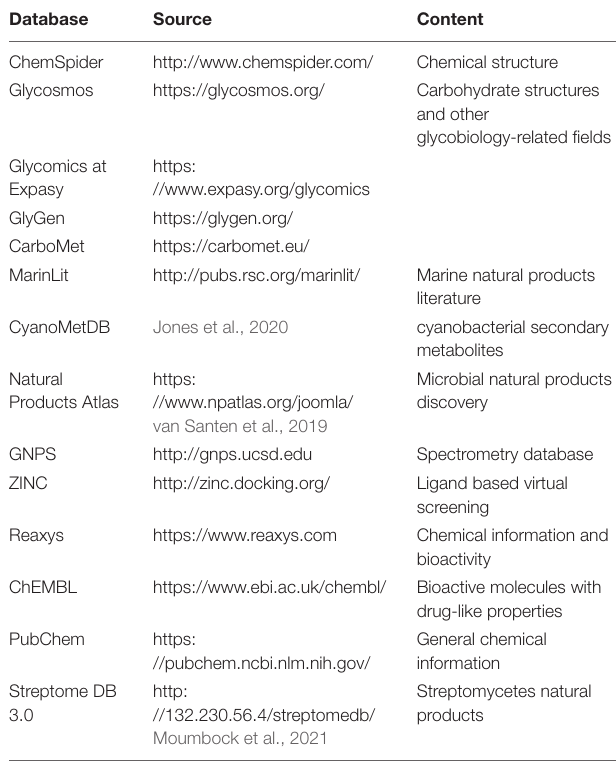
TABLE 2 | Overview of databases, useful for the marine biotechnology